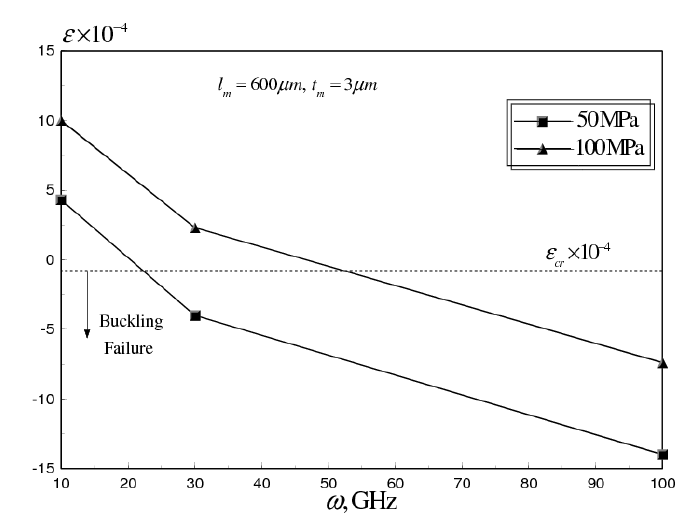
Figure 12. Effect of microfabrication mean residual stresses on ε of flat aluminum RF MEMS switch at operating frequency range of 10-100 GHz ( l t = 3 µm m